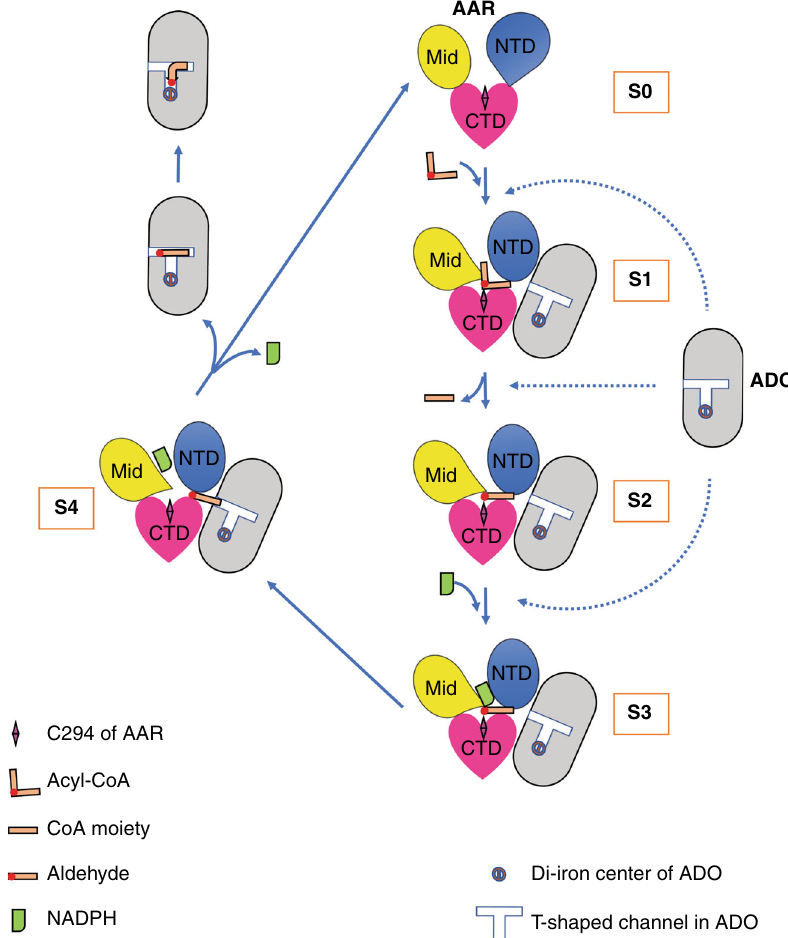
Fig. 5 Cartoon model of the proposed catalytic process of AAR in the two-step pathway. The NTD, mid-domain, and CTD of AAR are colored blue, yellow, and magenta, respectively. ADO is colored gray. Note that ADO may associate with AAR at several different states (such as S1, S2, and S3), since its binding is for assisting the aldehyde transferring, but not essential for substrate/NADPH